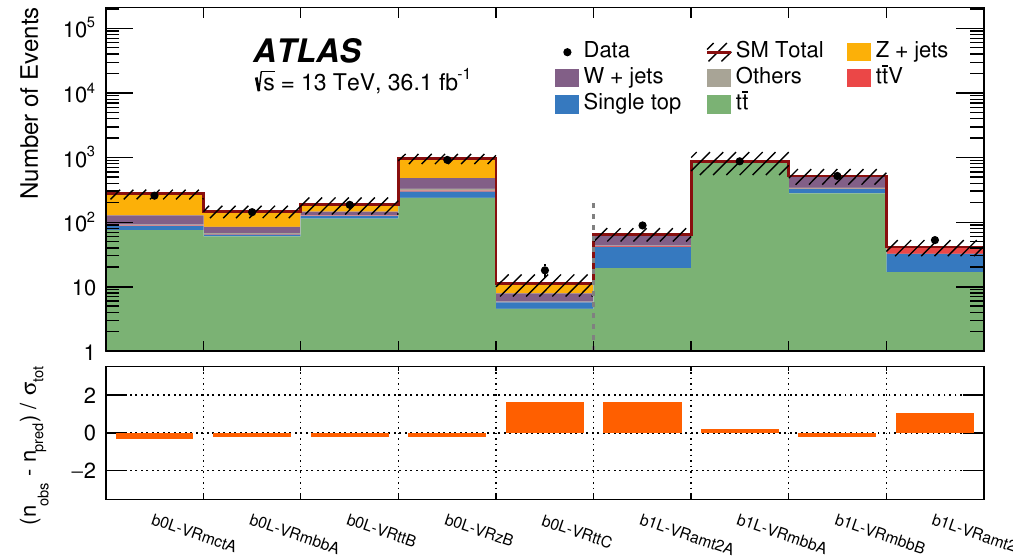
Figure 4. Results of the likelihood (cid:12)t extrapolated to the VRs associated with the b0L and b1L analyses. The normalization of the backgrounds is obtained from the (cid:12)t to the CRs. The upper panel shows the observed number of events and the predicted background yield. The contributions from diboson, multijet and rare backgrounds are collectively called \Others". All uncertainties de(cid:12)ned in section 7 are included in the uncertainty band. The lower panel shows the pulls in each VR, where (cid:27) tot is the error on the background estimation as a sum in quadrature of the systematic uncertainty and the statistical uncertainty on the